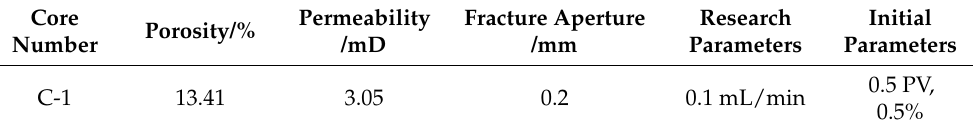
Table 11. Experimental scheme of CBG-SP in low-permeability fractured reservoirs.